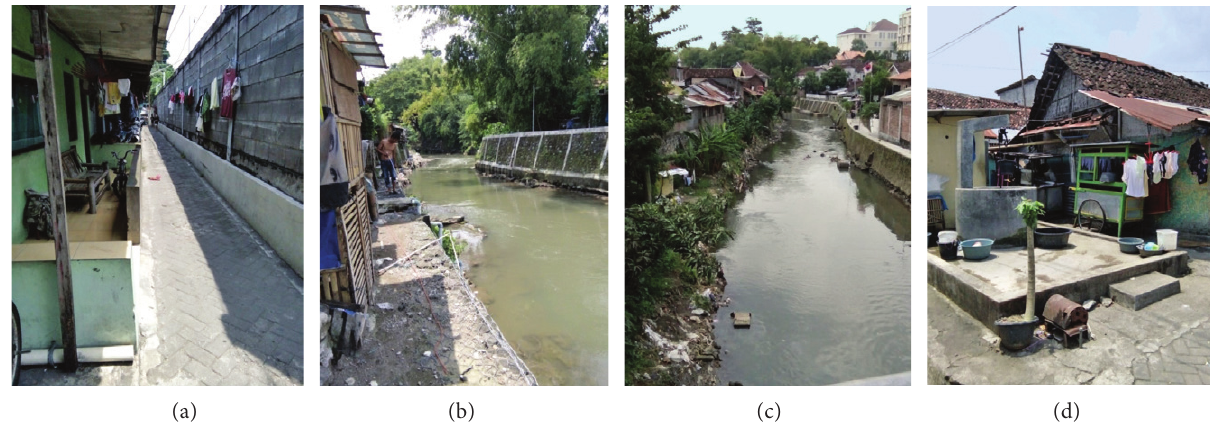
Figure 2. The real poor condition of Kampong Gampingan-Pakuncen: (a) The western access on the narrow concrete street; (b) The lack of space between the housing and the river; (c) A street al.ng the river is needed for vehicle